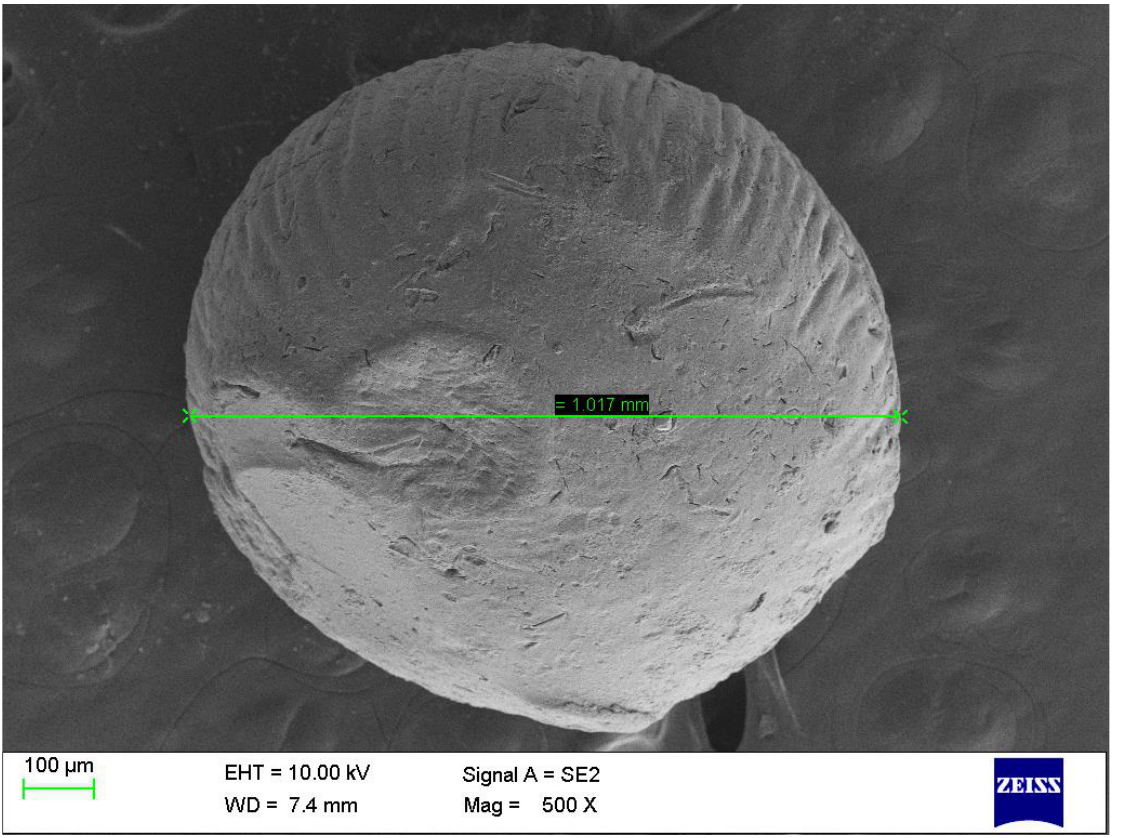
Figure 10. SEM image of the optimized